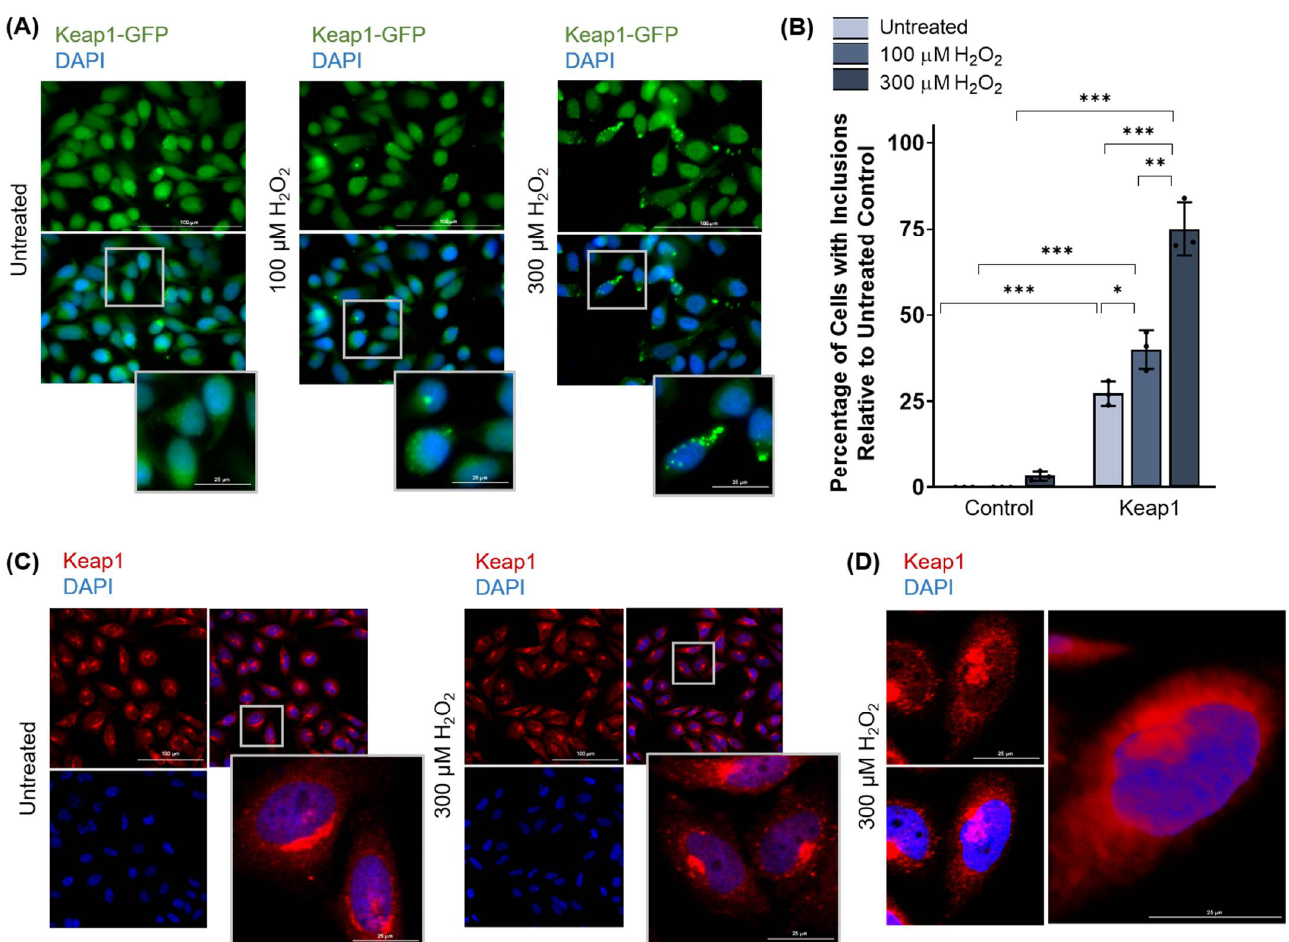
Figure 5. Keap1 forms inclusions upon exposure to high levels of oxidative stress in HeLa cells. ( A ) HeLa cells transfected with Keap1-GFP and treated with 100 or 300 µM H 2 O 2 for 3 h, visualized by fluorescence microscopy. ( B ) Quantification of Keap1-expressing cells with inclusions following hydrogen peroxide treatment in ( A ). Means derived from three biological replicates were used during the analysis. Means were analyzed using one-way ANOVA followed by Tukey’s post hoc test. Data are expressed as mean ± SD. p < 0.05 was considered statistically significant; * p < 0.05, ** p < 0.01, *** p < 0.001. ( C ) Confocal microscopy for Keap1-expressing cells treated with 300 µM H 2 O 2 for 3 h, visualized by immunofluorescence microscopy. ( D ) Confocal microscopy with Z-stacking for Keap1-expressing cells treated with hydrogen peroxide, visualized by immunofluorescence, and demonstrating that Keap1 inclusions are cytosolic.